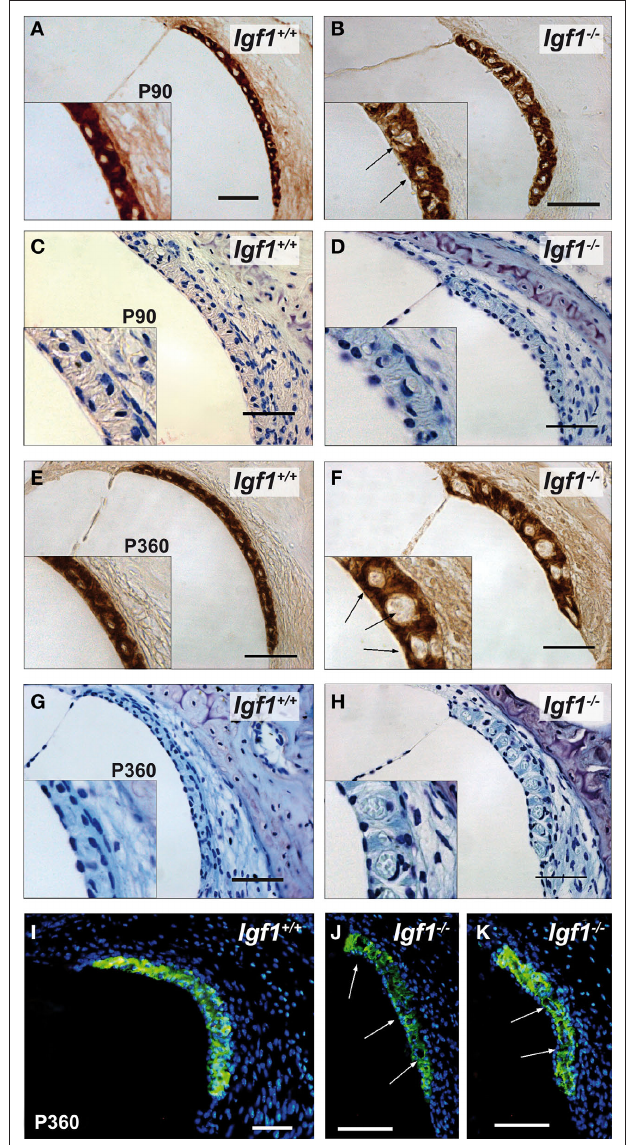
Figure 6 | Comparative study of the stria vascularis with the aging of Igf1 + / + wild type and Igf1 − / − null mice. Na-K-ATPase (A,B,e,F) and cresyl violet staining (C,D,g,H) expression in the stria vascularis of 3- (A–D) and 12-month-old mice (e–H) showing the morphological differences associated with the aging of each genotype. The stria vascularis in the Igf1 − / − mice had an abnormal morphology, it was shorter and thicker, and with evident dilation of the vascular spaces (arrows). Kir4.1 (KCNJ10) expression (i–K) in the stria vascularis of aged null mice was altered and there was a relative loss of expression in the stria and sacular dilations. Four to six mice per condition were analyzed. Scale bar 50